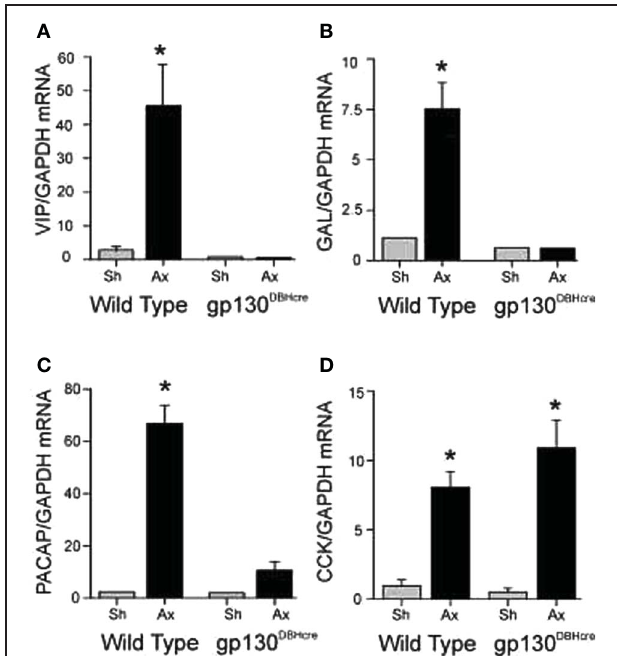
FIGURE 1 | Regulation of mRNA expression for several neuropeptides in the SCG after unilateral axotomy. Wild type and gp130 DBHcre mice were subjected to unilateral axotomy of the SCG, and mRNA levels for several neuropeptides and proteins were measured 48h later in the ipsilateral (Ax) and contralateral (Sh) ganglia. The data are expressed relative to GAPDH mRNA in the same samples and represent the means ± S.E.M. of 4–5 ganglia for VIP (A) , galanin (B) , and PACAP (C) . These three mRNAs increased in the ipsilateral ganglia of the wild type mice 16-, 7-, and 28-fold, respectively, but did not increase in ganglia from knockout animals. However, cholecystokinin (CCK) mRNA was increased similarly in axotomized ganglia of mice of both genotypes (D) . ∗ Indicates p < 0 . 05 compared to sham-operated ganglia of the same genotype compared by Student’s t -test. The figure is from Habecker et al.